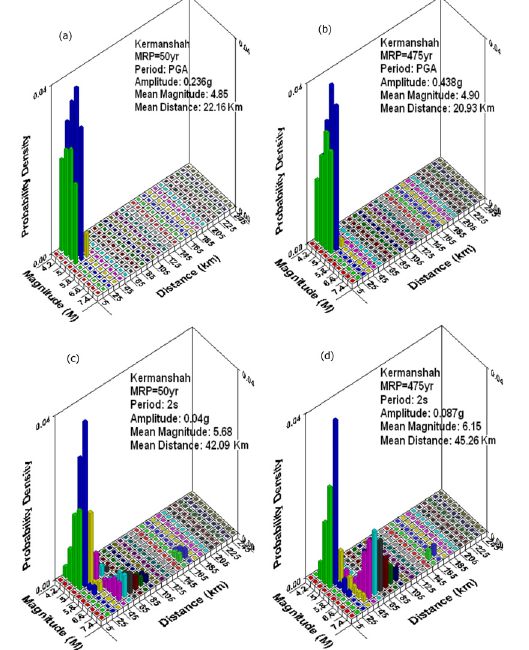
Figure 7. Disaggregated seismic hazard for a site in Kermanshah for 63% and 10% in 50 years probability of exceedances for PGA and Sa(0.2 s). Bins of width 0.4 in magnitude, 10 km in distance, and 0.2 in ε are